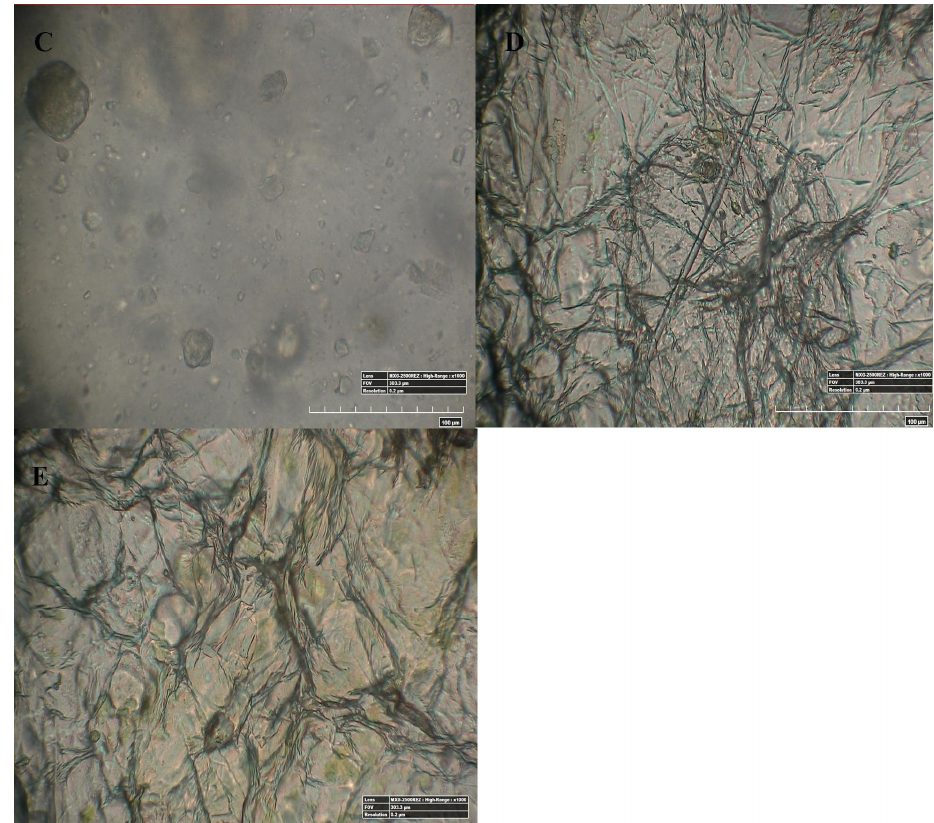
Figure 5. 50×, 100× and 1000× image using 3D Hirox digital microscopy. ( A ) nHA nanorod distribution in pristine mPE ‐ nHA at 50×; ( B ) Thickness of Aloe vera coating in 24 h Aloe vera dip ‐ coated mPE ‐ nHA at 100×; ( C – E ) are 1000× images of untreated mPE ‐ nHA, and 12 and 24 h Aloe vera dip ‐ coated mPE ‐ nHA, respectively.